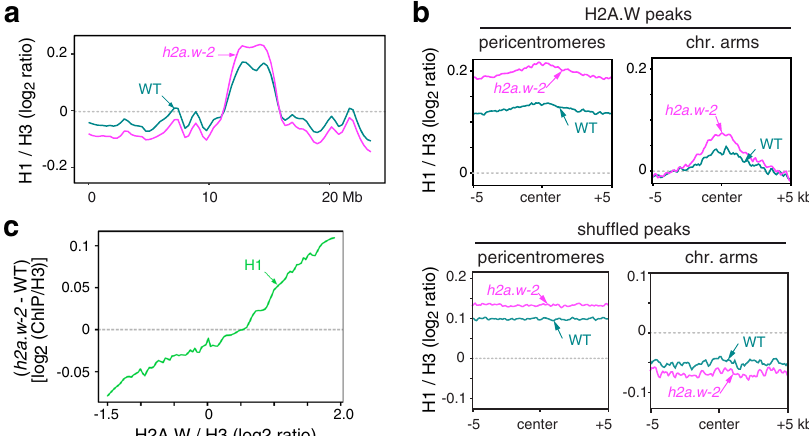
Fig. 5 H2A.W antagonizes histone H1 deposition in heterochromatin. a Locally weighted scatterplot smoothing (LOESS) fi t of H1 levels averaged in 1 kb bins across chromosome 3 in WT and h2a.w-2 . Average of two replicates shown. b Metaplots of average H1 levels from two replicates over H2A.W peaks in pericentromeres and the chromosome arms (top panel). Plots over randomly shuf fl ed peaks within the chromosome arms and pericentromeres are shown for comparison (bottom panel). c Smoothing spline fi ts (50 degrees of freedom) of change in H1 levels ( h2a.w-2 minus WT; log 2 ChIP/H3) in 1 kb windows plotted against WT H2A.W level. Source data underlying Fig. 5a are provided as a Source Data fi